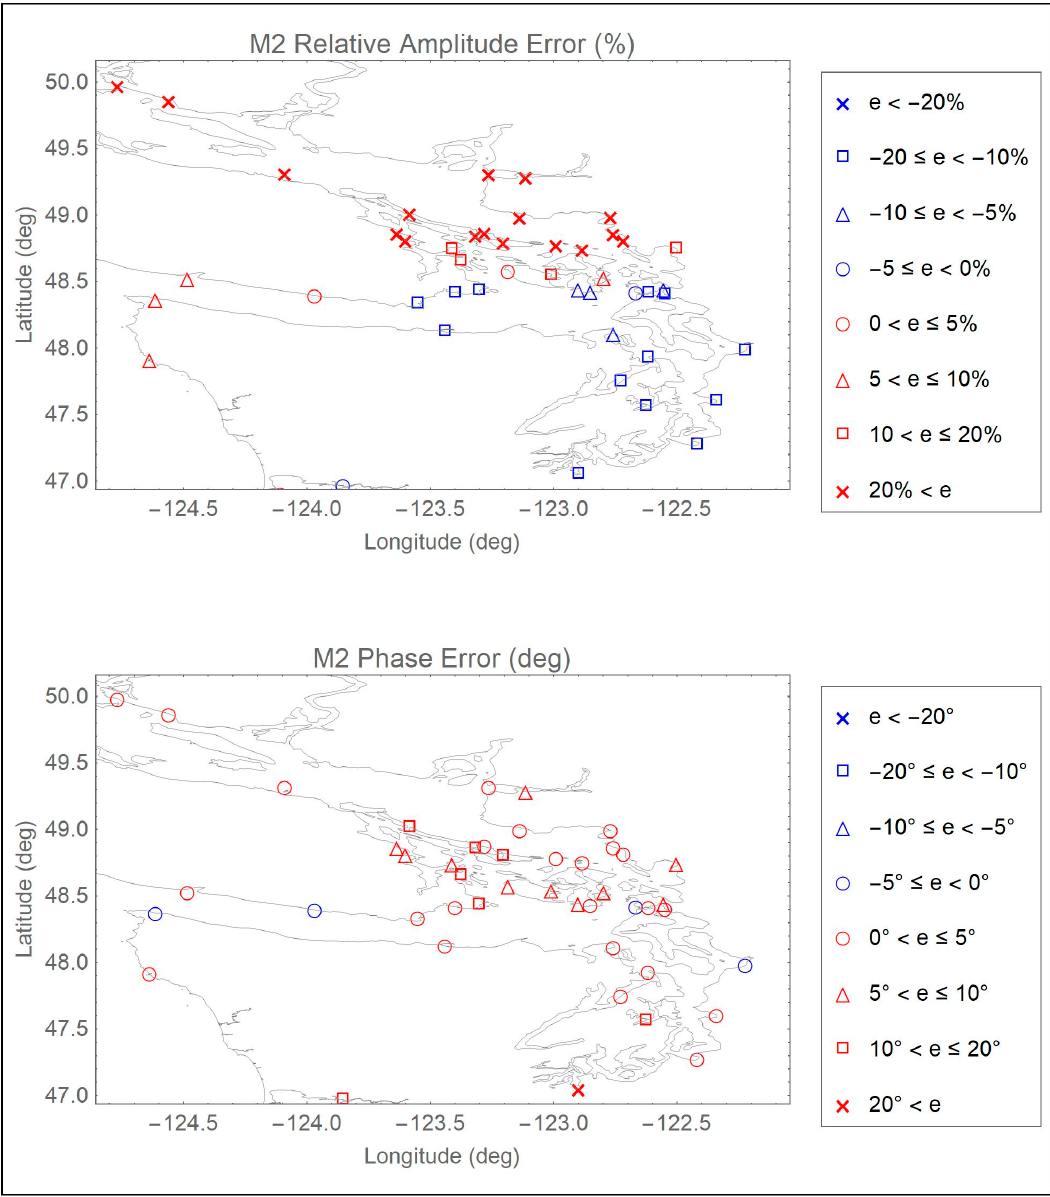
Figure A19. Distribution of ENPAC15 relative amplitude (%) and absolute phase (deg) errors for the M 2 constituent: Puget Sound view.